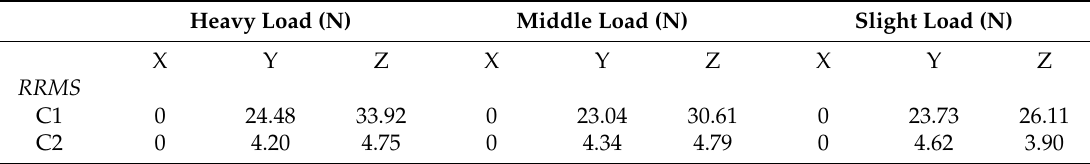
Table 5. Comparison of the maximum RRMS with adding disturbance (%). Heavy Load (N) Middle Load (N) Slight Load